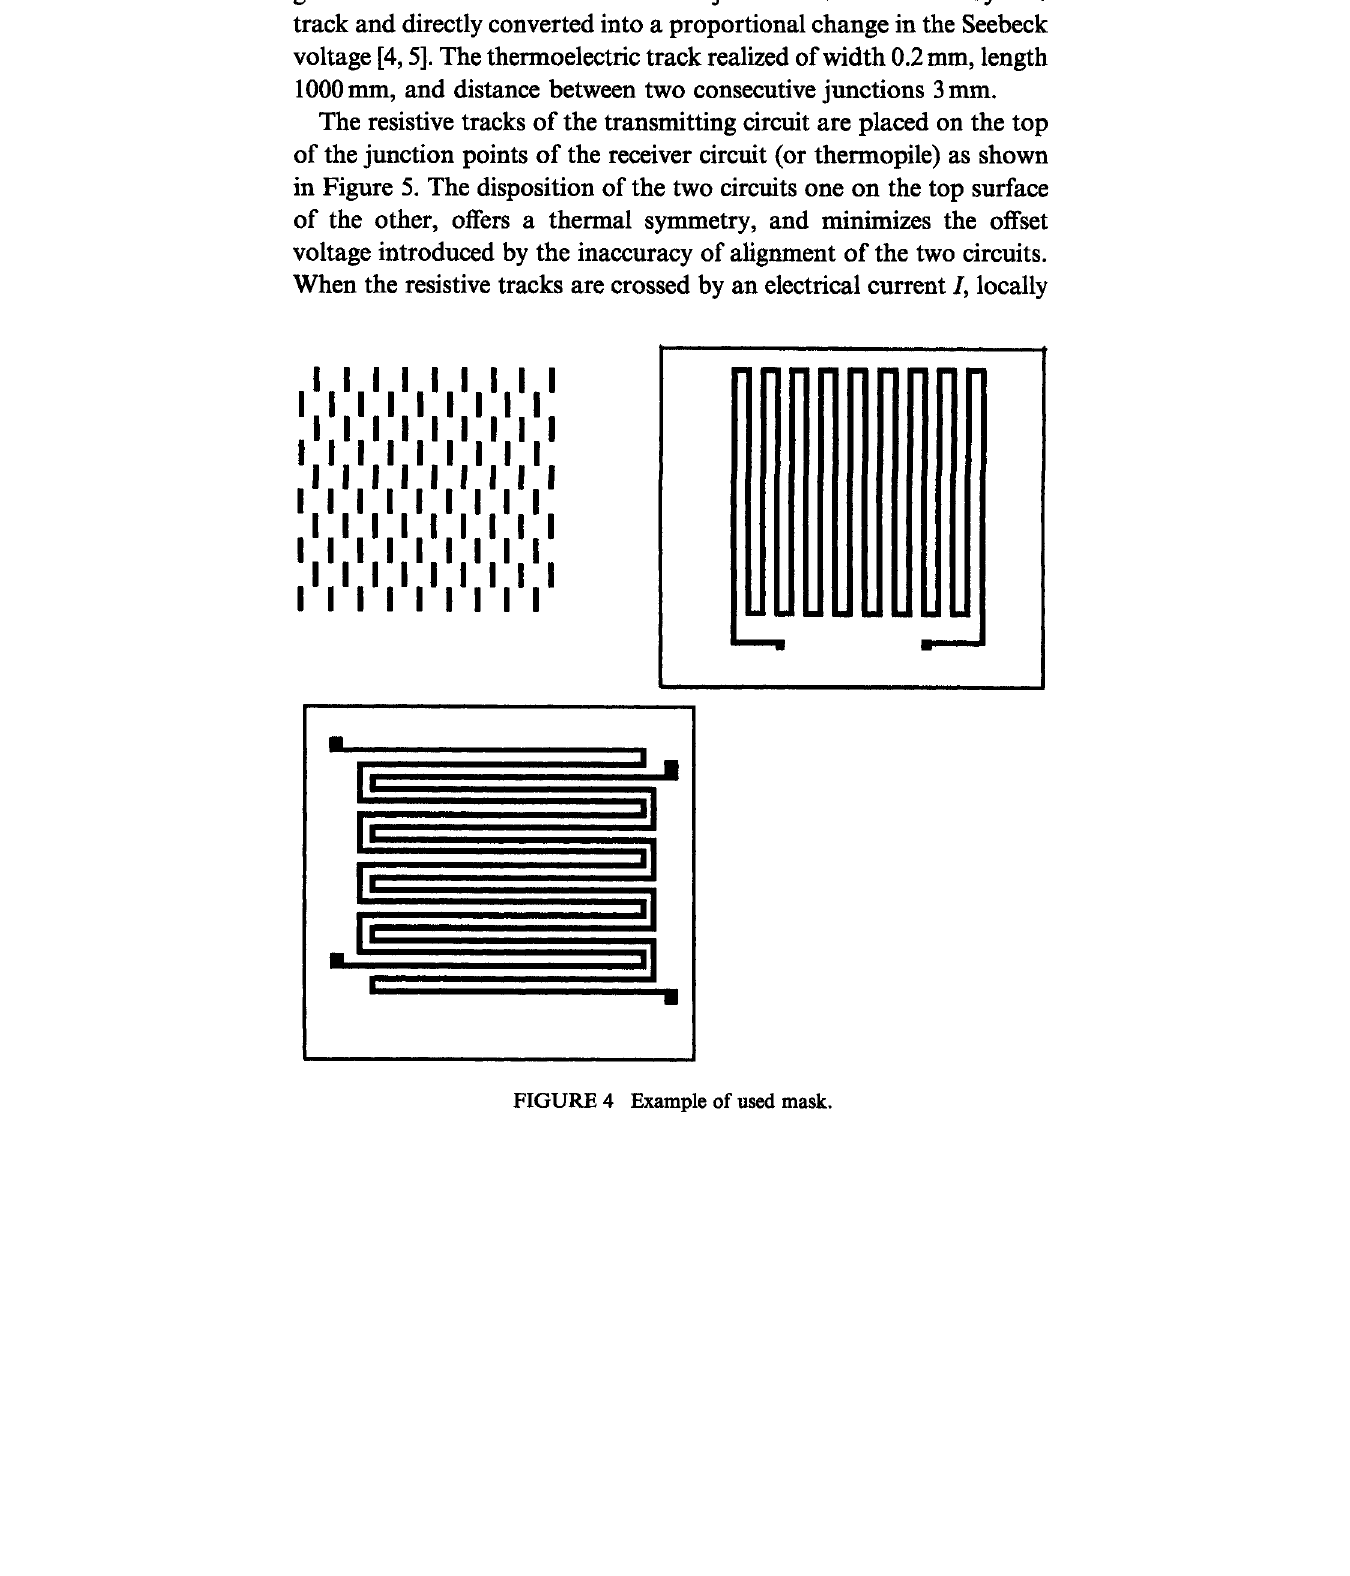
FIGURE 4 Example of used